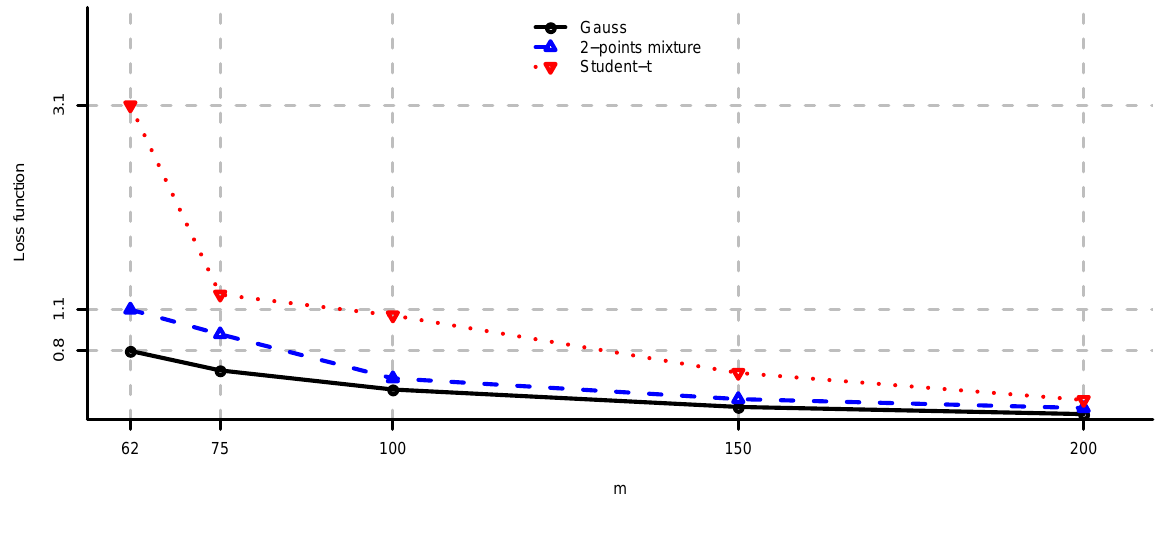
Figure 6. As in Figure 4 where c